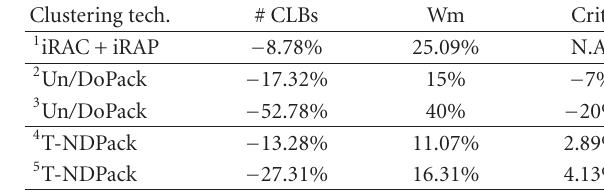
Table 8: T-NDPack versus other clustering techniques: based on reported performance over T-VPack (positive percentage means improvement), #CLBs: increase in number of CLBs; Wm: minimum channel width reduction; Crit.: critical path delay reduction. Clustering